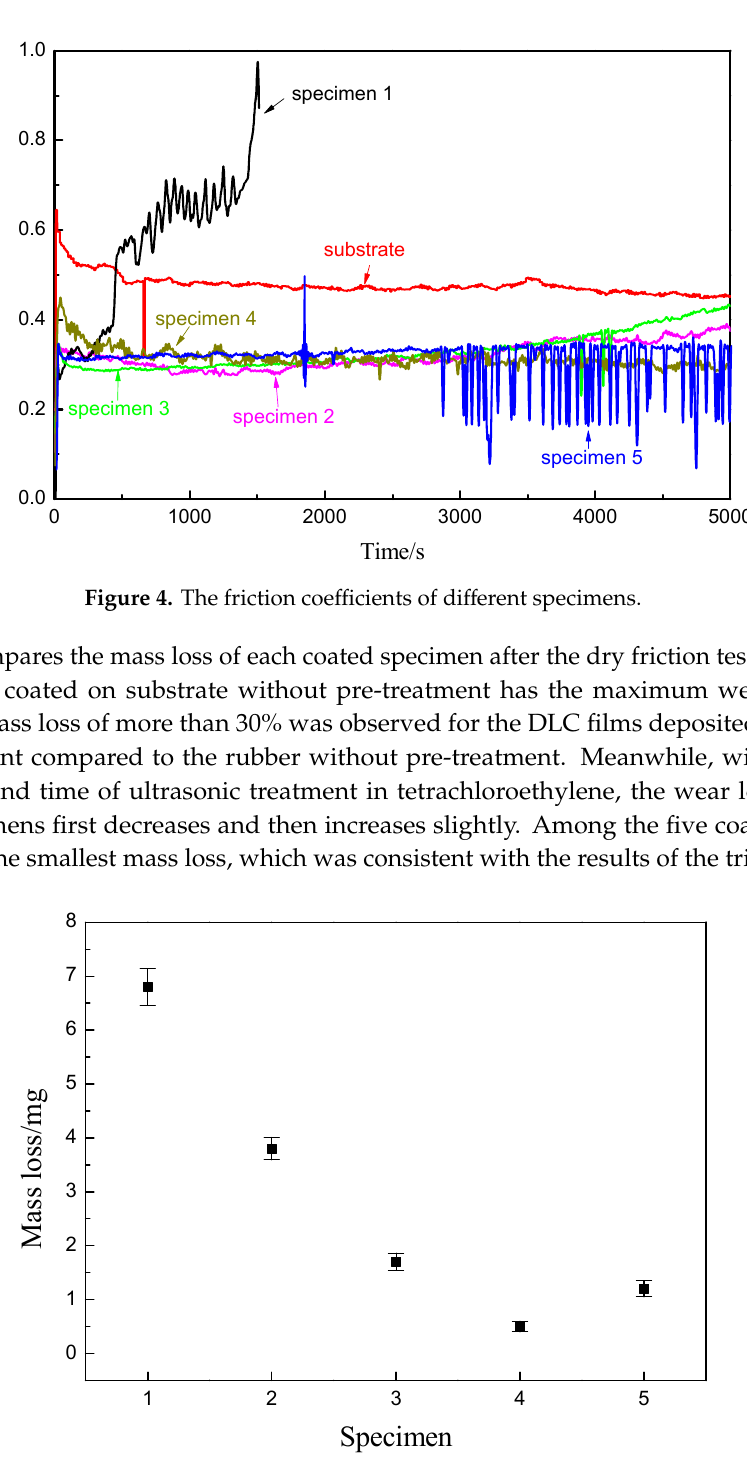
Figure 5. Mass loss of specimens under a dry friction condition.